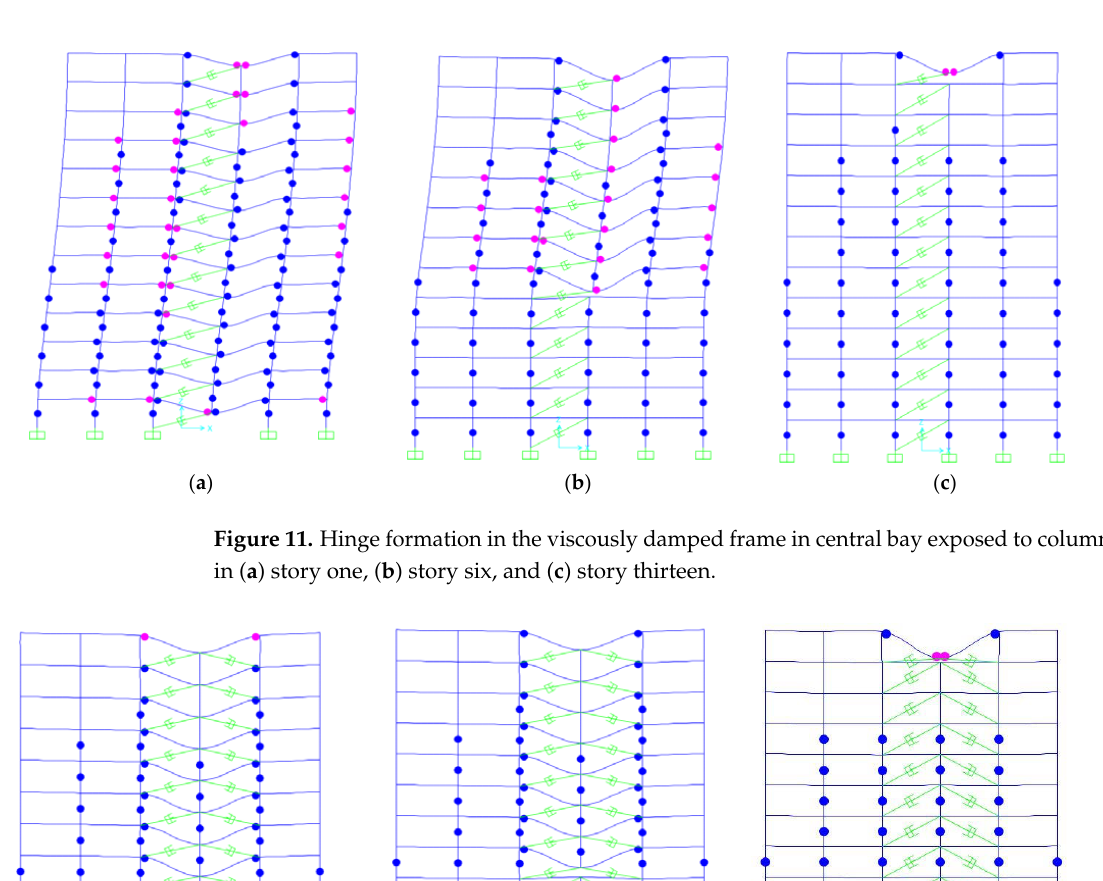
Figure 12. Hinge formation in the viscously damped frame in two inner bays exposed to column removal in ( a ) story one, ( b ) story six, and ( c ) story thirteen.